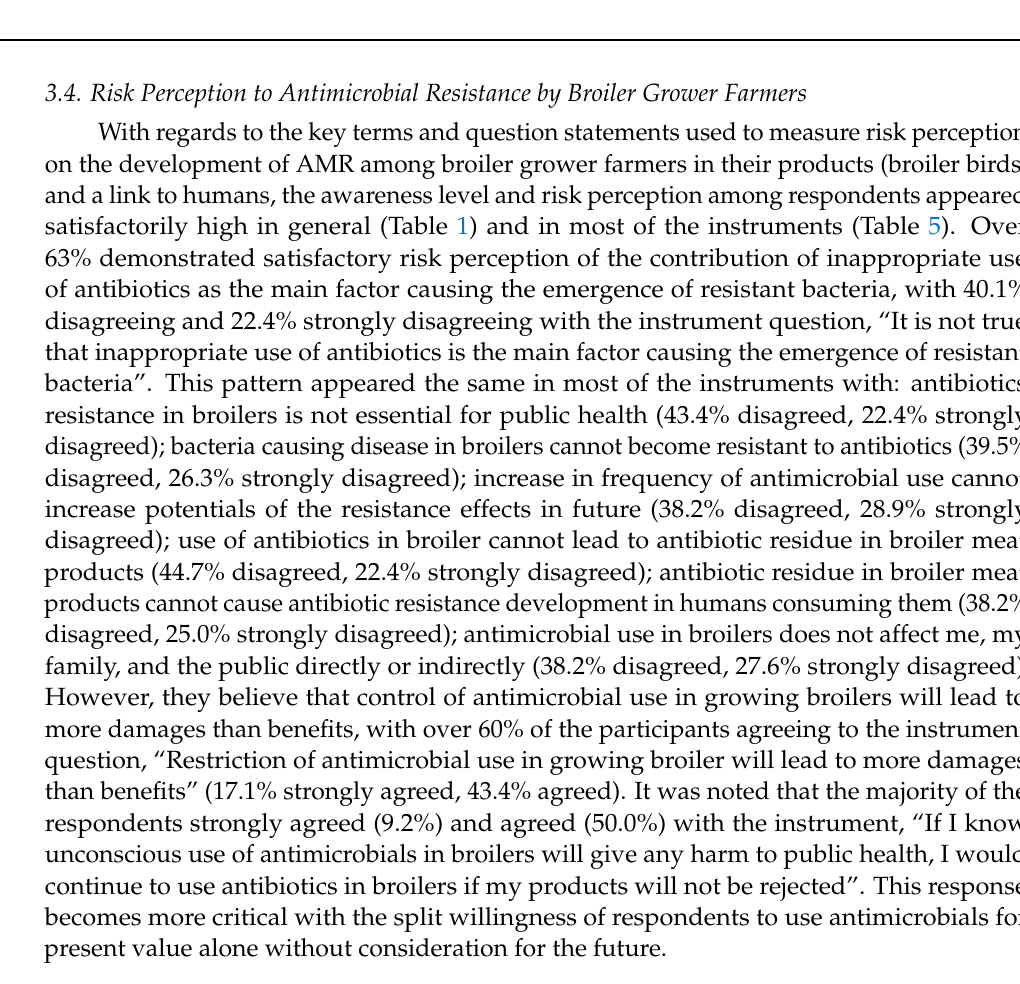
Table 5. Risk perception to antimicrobial use and resistance by broiler grower